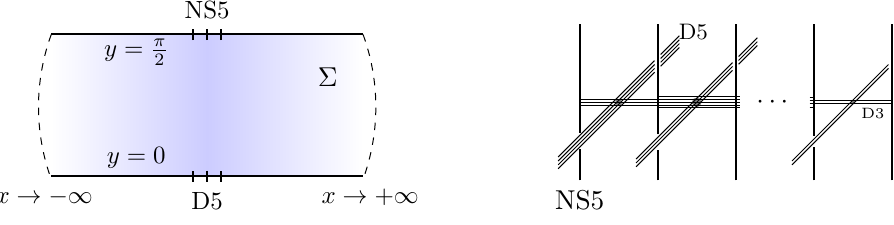
Figure 3 . Left: AdS 4 × S 2 × S 2 × Σ solutions for gravitating baths. The AdS 5 × S 5 region is closed off; the limits x → ±∞ both lead to regular points in the internal space. This leaves the 3d conformal boundary of AdS 4 , corresponding to the remaining point of the conformal boundary in figure 1(b). Right: the associated brane configurations have no semi-infinite D3-branes, only D3-branes suspended between